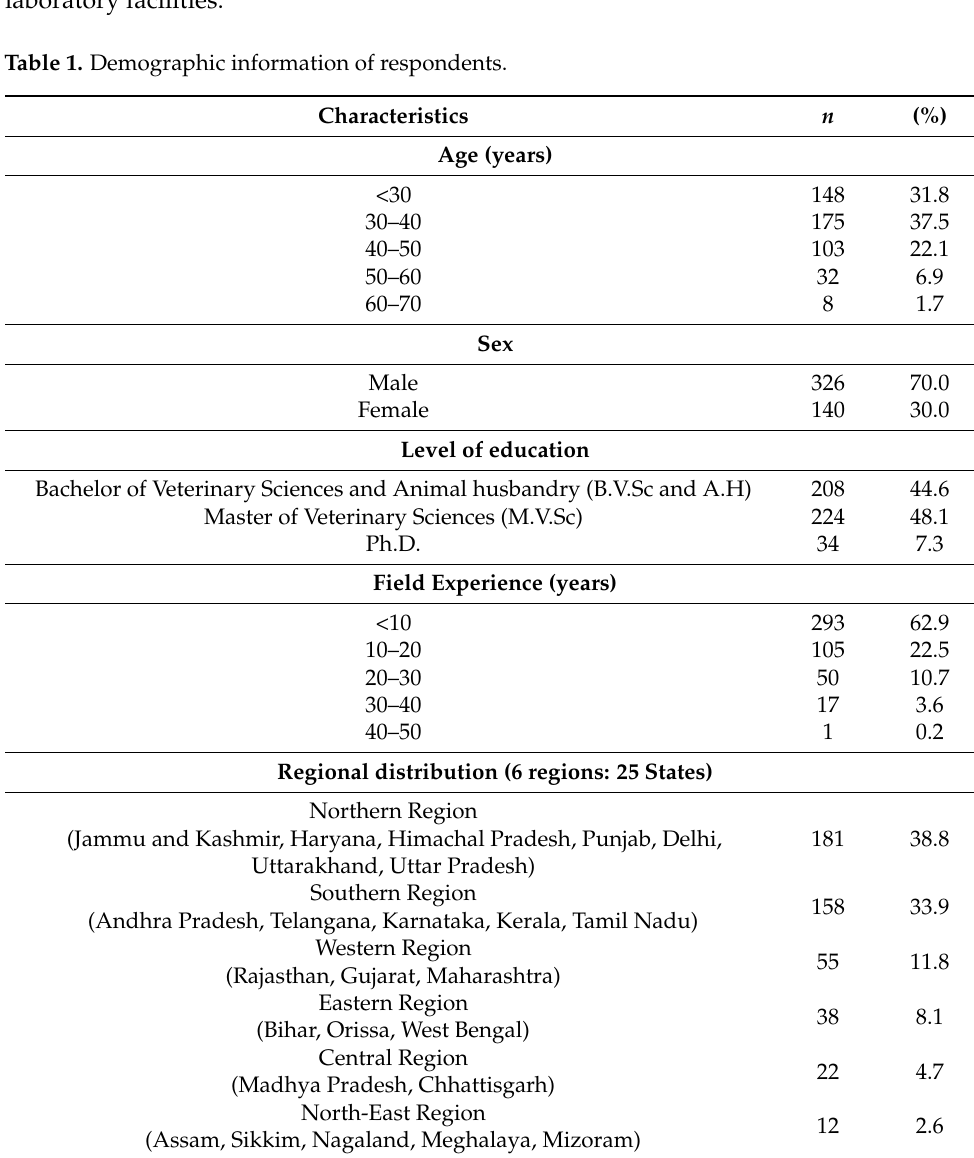
Table 1. Demographic information of